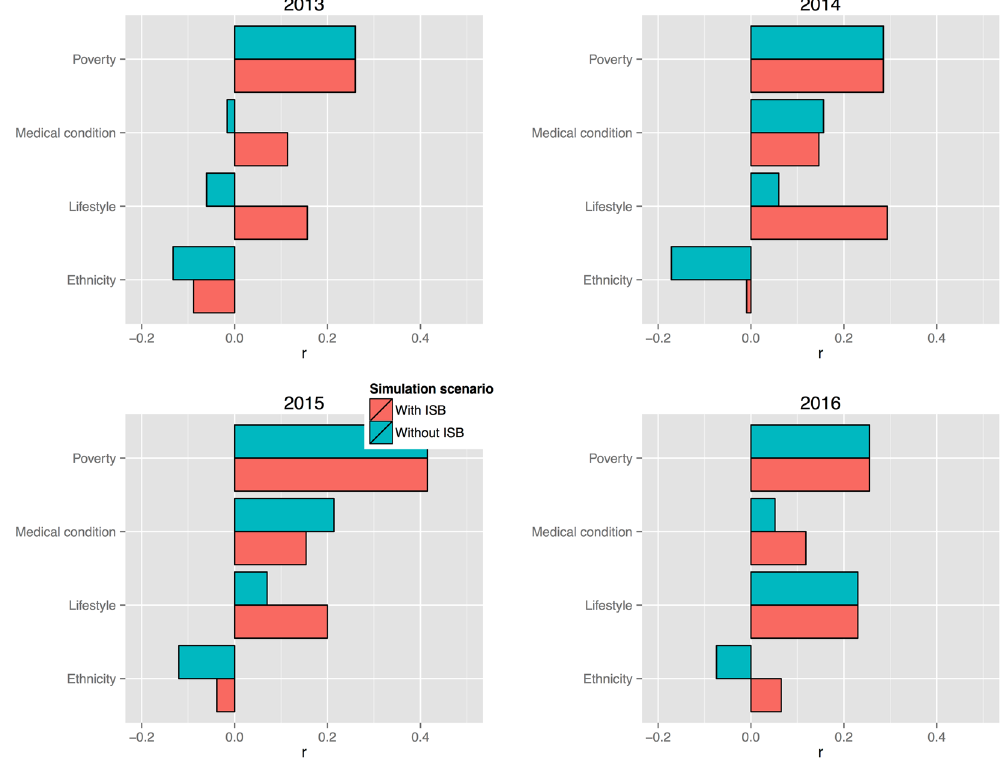
Figure 6. Correlation propensity between keywords, associated with the main risk topics and generic search term ‘diabetes’. Fisher-transformed r s indicate stronger correlation trends for the case of the modeling scenario, comprising self-diagnosis variable (‘With ISB’). Topics consist of the following risk factor components: Poverty (Without ISB): ‘Barriers to housing’, ‘Poor indoors living conditions’; Medical condition (Without ISB): ‘Obesity’, ‘Rheumatism’, ‘Acne’, ‘Eczema’, ‘Anxiety’; Lifestyle (Without ISB): ‘Smoking’; Ethnicity (Without ISB): ‘Pakistani’, ‘Irish’, ‘Celtic’, ‘Black Caribbean’; Poverty (With ISB): ‘Barriers to housing’, ‘Poor indoors living conditions’; Medical condition (With ISB): ‘Insomnia’, ‘Dermatitis’, ‘Acne’, ‘High cholesterol’, ‘Anxiety’; Lifestyle (With ISB): ‘Sometimes/Rarely diet’, ‘Use slimming products’, ‘Trying to lose weight’; Ethnicity (With ISB): ‘Irish’, ‘Somali’, ‘Sikh’, ‘Eastern European’, ‘Black Caribbean’. Data source: Google